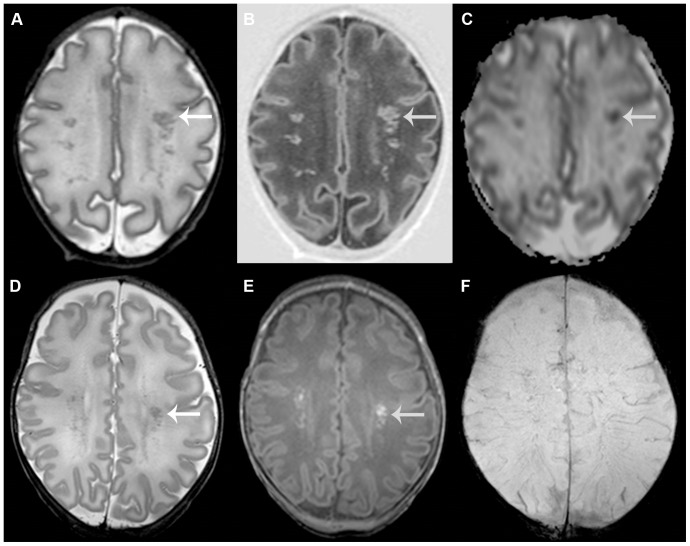
Punctate white matter lesions with a cluster pattern.Early (A–C) and term equivalent (D–F) scans in an infant of 31+3 weeks gestation with lesions in a cluster pattern. T2-weighted imaging shows multiple lesions throughout the white matter (A) that are also clearly visible on inversion recovery imaging (B). The apparent diffusion coefficient -map shows restricted diffusion at the site of the lesions (C). The SWI sequence (not shown) did not show any signal loss. The arrow indicates one of the lesions, visible on all images. At term equivalent age, lesion load has diminished. Lesions are now better appreciated on T1-weighted imaging (E), compared with T2-weighted imaging (D). Again, SWI does not show signal loss (F). Outcome was favorable with a developmental quotient of 94 on the Griffiths scales at 18 months corrected age.